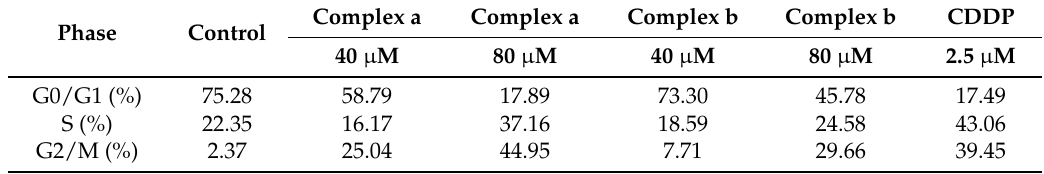
Figure 6. Propidium iodide (PI) assay of A549 cell lines treated by complexes a / b and CDDP. Table 2. Cell cycle distribution of A549 cell lines induced by complexes a / b and